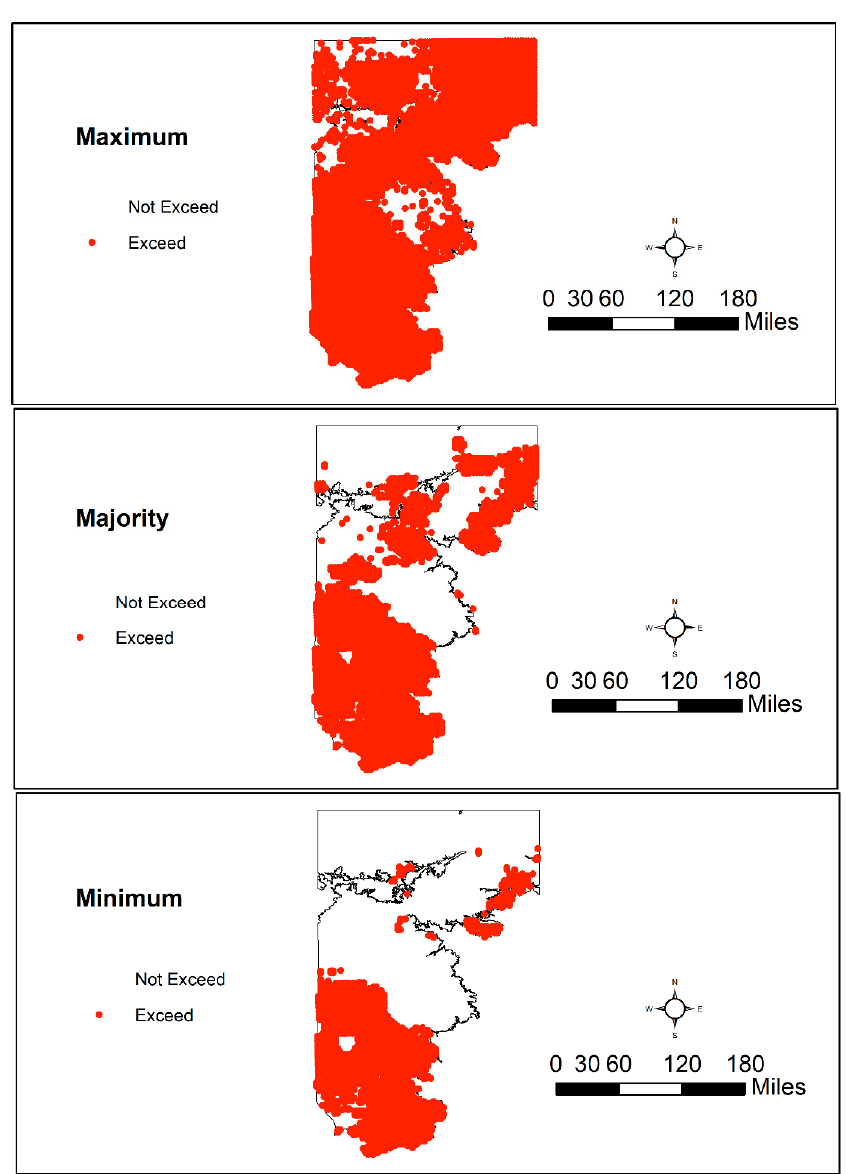
Figure 10. Prediction of Nitrate Exceedance across the Study Area by Different Methods.